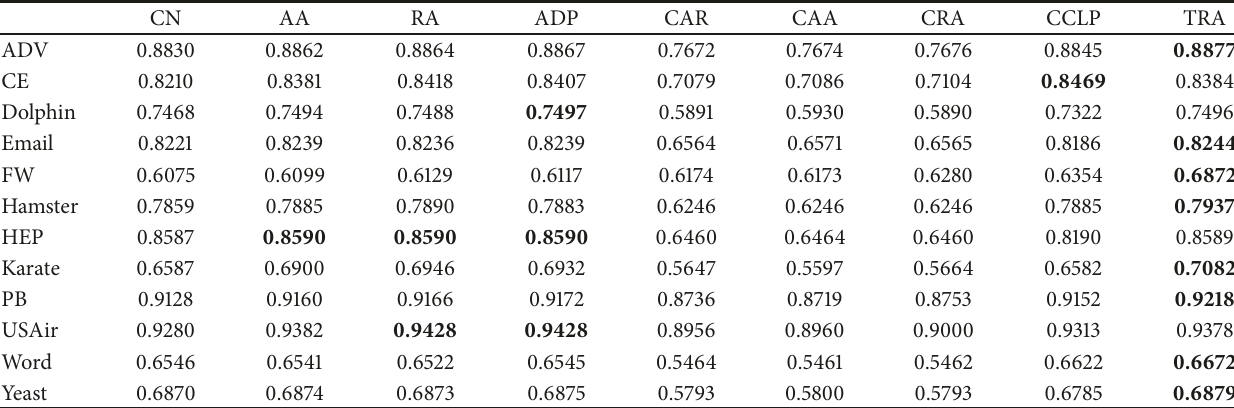
Table 4: The AUC of different methods in 12 networks. The results are the average of 50 independent implementations with |𝐸 𝑡𝑠 |/|𝐸| = 0.2 . The best performance for each network is emphasized by boldface.